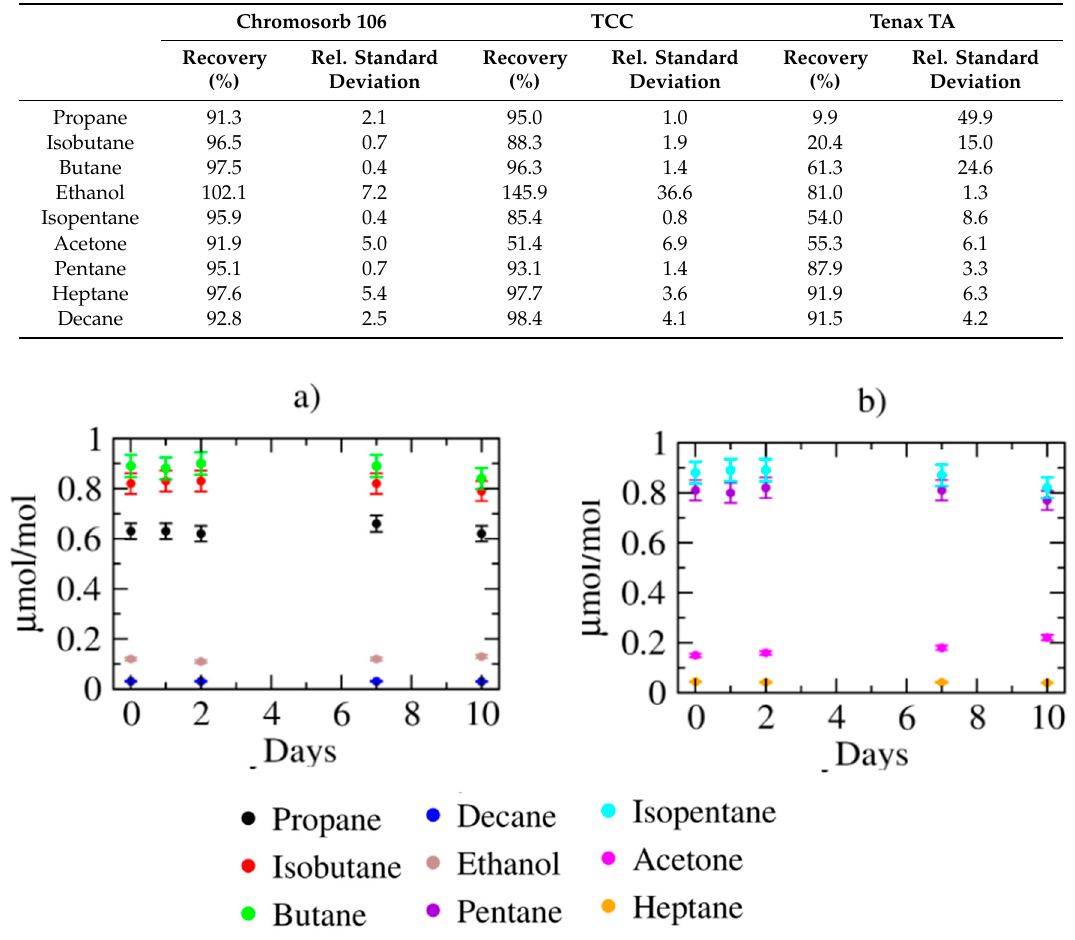
Figure 1. Storage stability of hydrocarbons on Chromosorb 106. ( a ) for butane, propane, isobutane,